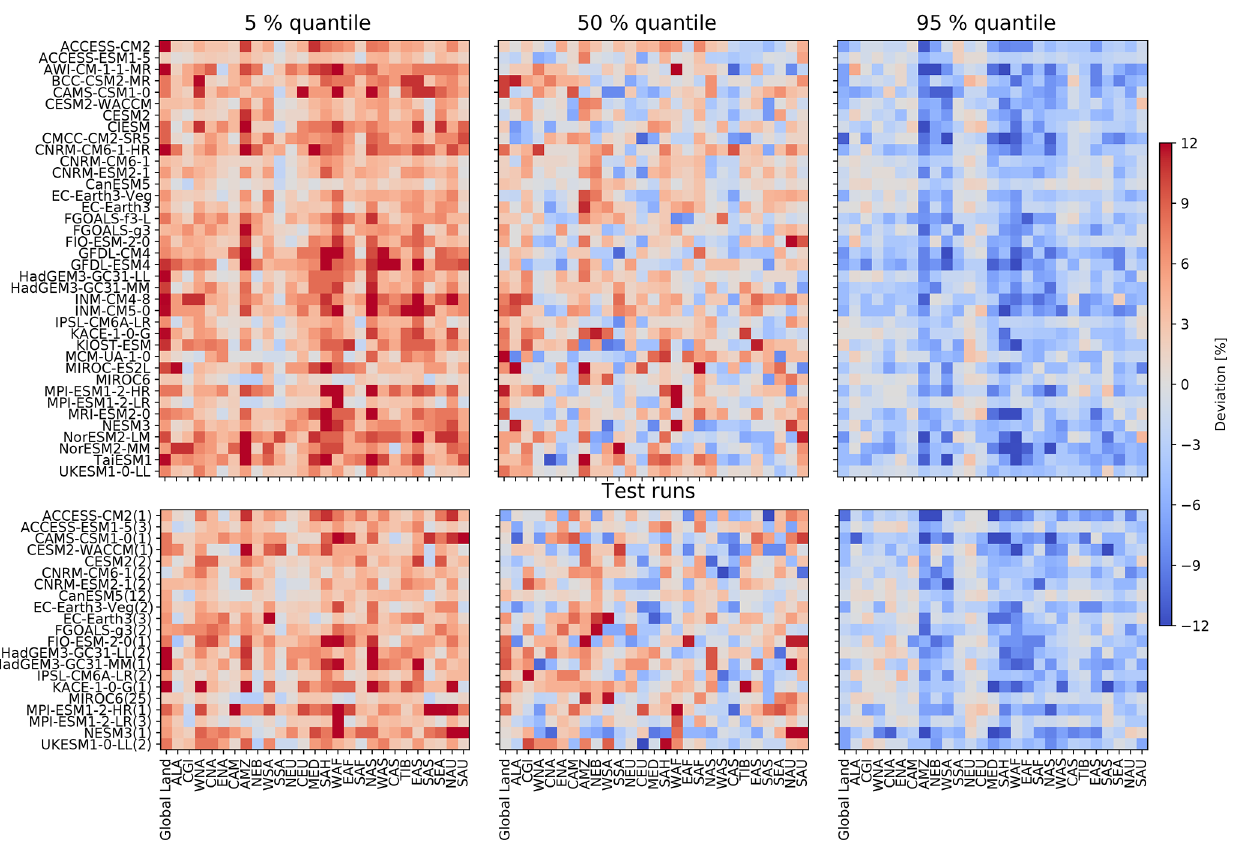
Figure 10. Same as Fig. 8, but over the period